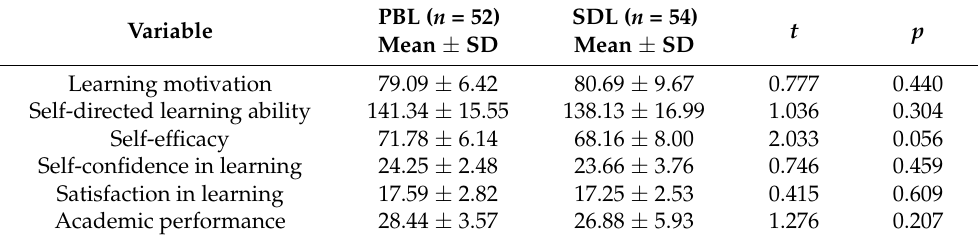
Table 2. Homogeneity of dependent variables pre-intervention.